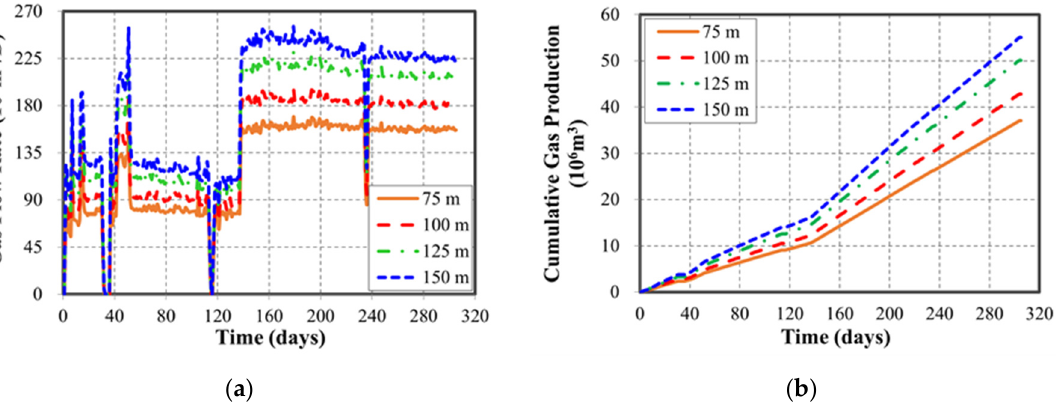
Figure 6. Production with different hydraulic fracture half-lengths: ( a ) gas flow rate; ( b ) cumulative gas production. gas